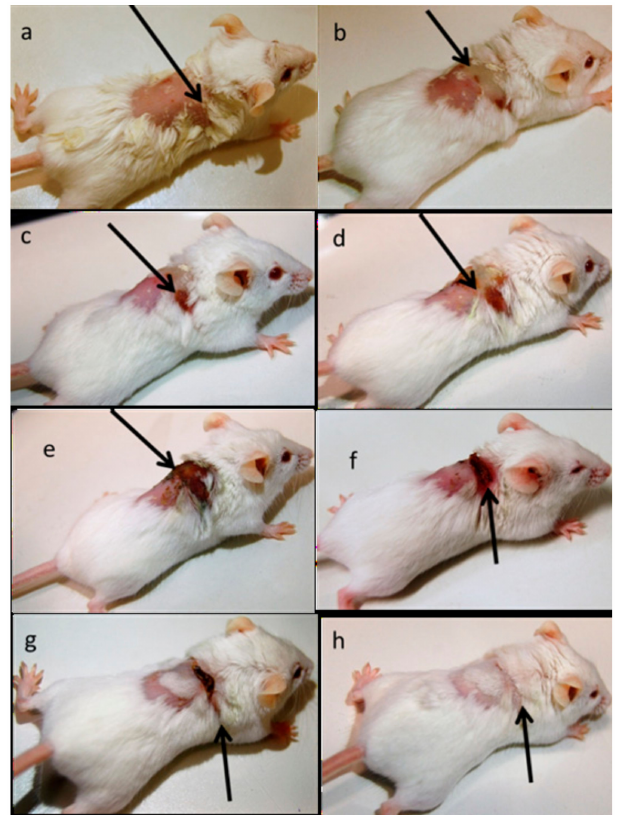
Figure 10. In vivo infection model preparation, treatment, and recovery: ( a ) after bacterial infection dose, ( b ) day 1 Infection initiation, ( c ) day 2 Infection and wound growth, ( d ) day 3 inflammation and swelling, ( e ) day 6 no significant changes were observed, ( f ) day 9 wound started to heal, ( g ) day 12 wound started to heal, ( h ) day 15 fully recovered.